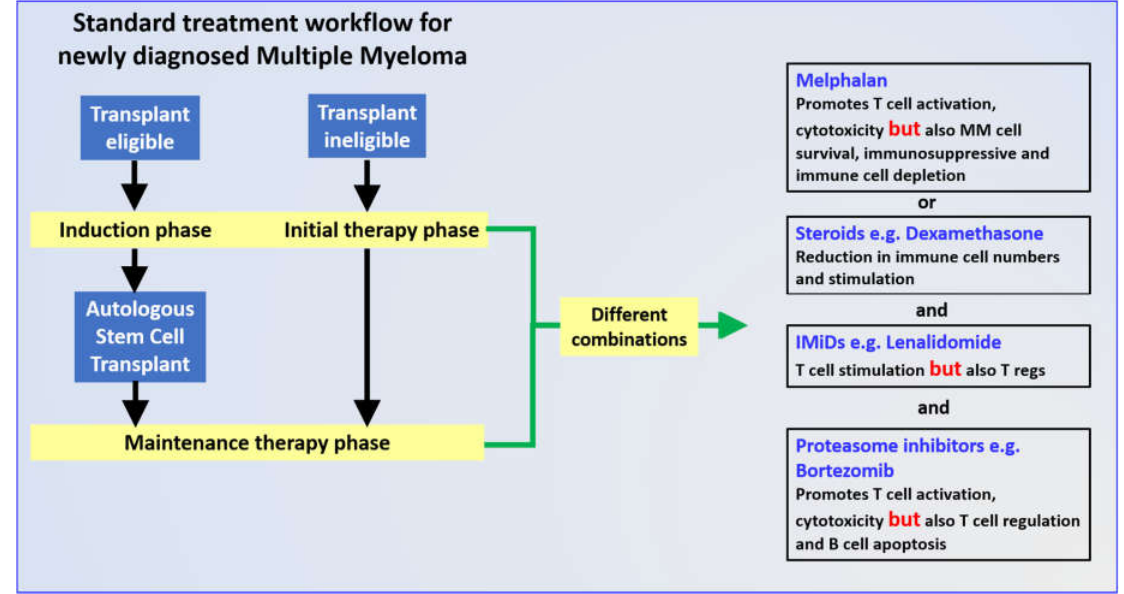
Figure 2. Unresolved issues regarding the impact of commonly used drugs on the immune responses of patients with multiple myeloma. Some drugs can have both immunostimulatory and regulatory effects. Their combination may impact the ability of the patient to mount effective, long-term anti-tumor immunity. Further research in clarifying these effects, especially with in vivo systems, may lead to effective drug therapy and improved patient survival.